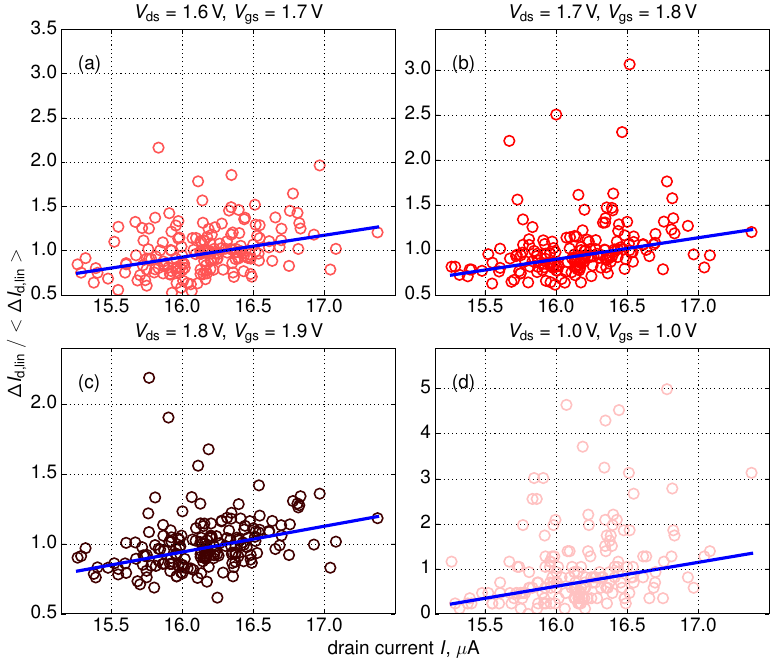
( 0 ) currents. Data for all four stress conditions and d,lin